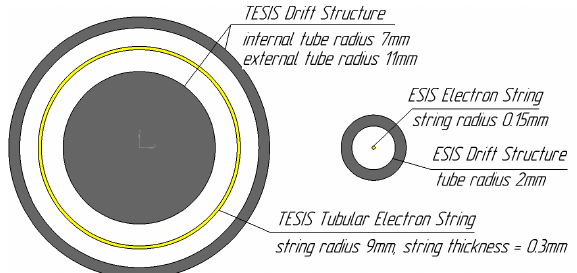
Figure 2. TESIS (left) and ESIS (right) drift structure cross sections. In TESIS, it is planned to form a tubular electron string with 1m length, 9mm internal radius and 0 . 3mm thickness. Volume occupied by the string in TESIS almost 200 times larger than in ESIS, providing corresponding increase in ion